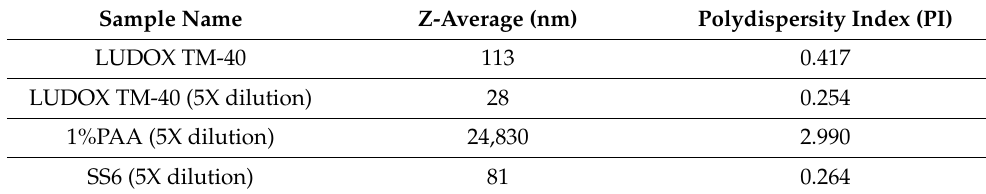
Table 3. The Particle Size in Suspension by DLS analysis.